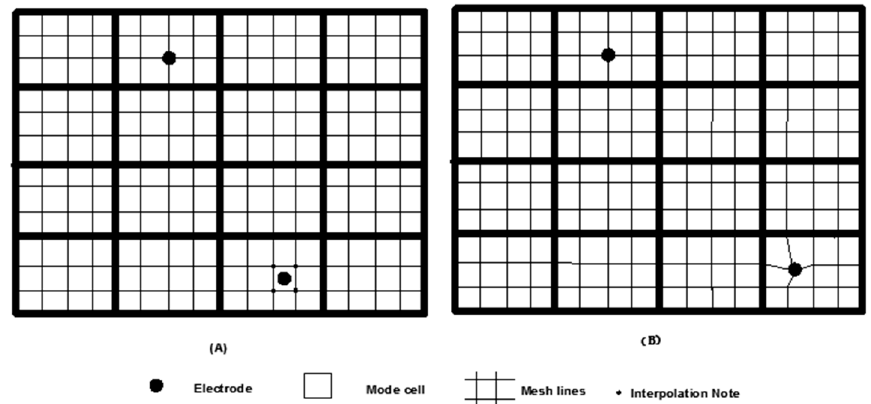
Figure 5. Non-grid electrode treatment methods: ( A ) Interpolation alternative method; ( B ) peripheral potential alternative method.